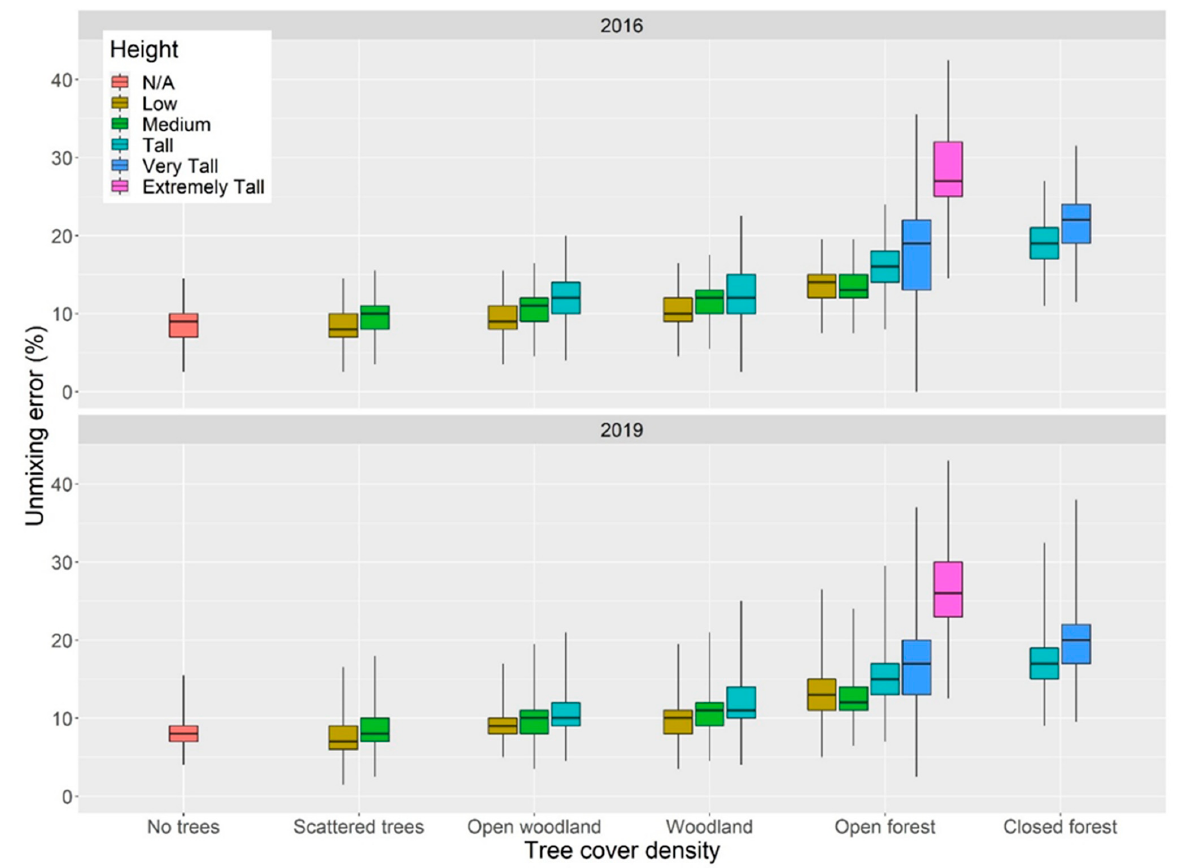
Figure 9. Box plots showing year 2016 ( top ) and year 2019 ( bottom ) median unmixing error distri-